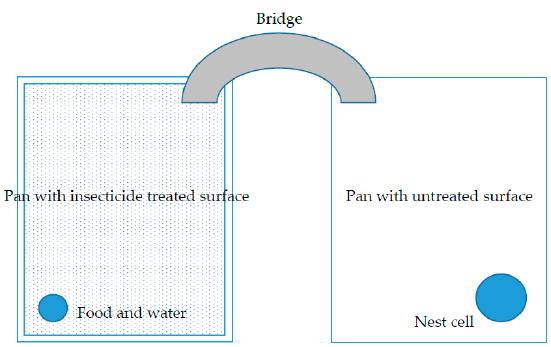
Figure 2. Experimental set-up of laboratory bioassay evaluating repellency and efficacy of commercially available insecticides against Nylanderia fulva . The interior dimensions of each arena were 31 × 21 × 5 cm. Insecticides were applied to a painted wood panel that was then attached to the bottom of one pan (shaded area). An artificial nest with 2000 workers and 15 queens (no brood) was placed into the untreated pan. Worker ants were required to cross the length of the insecticide treated arena for food and water.